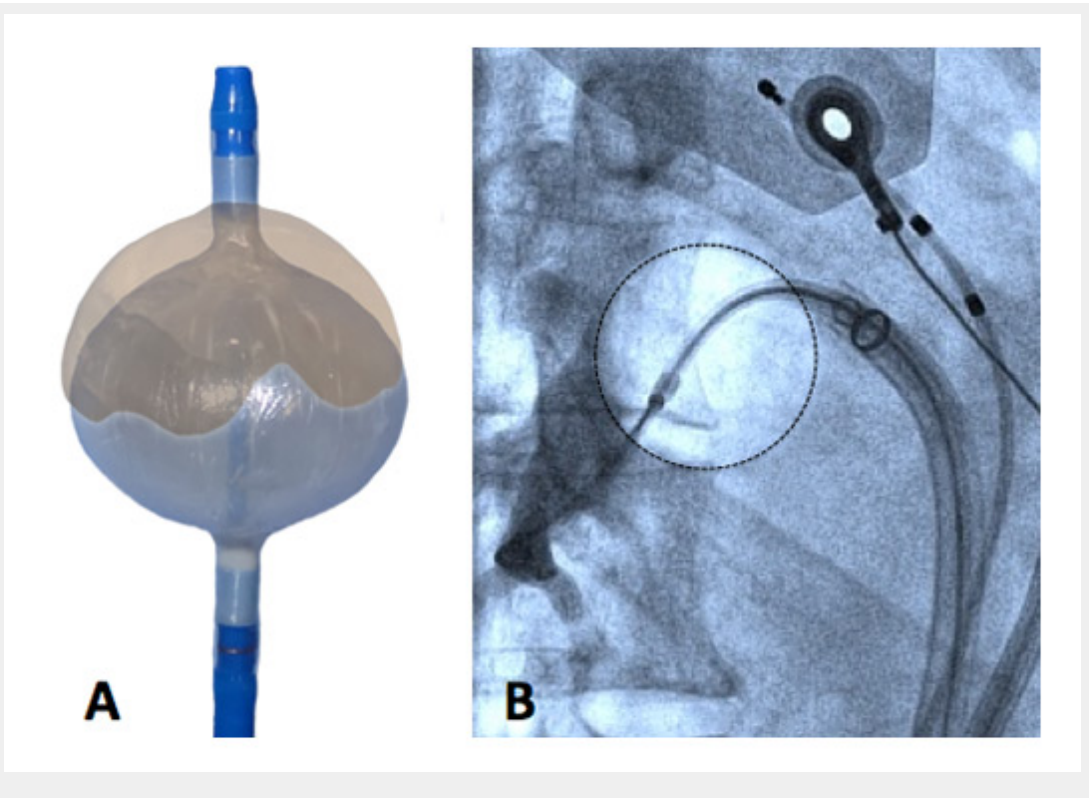
Figure 4 A: The cryoballoon is a balloon-based ablation system used for pulmonary vein isolation. The inflated cryoballoon has a diameter of 28 mm. The grey overlay shows the area where ice forms on the balloon during ablation. B: Fluoroscopic image before ablation at the right inferior pulmonary vein using the 28 mm cryoballoon. The actual balloon is encircled by a dotted line. Contrast media is injected into the pulmonary vein before ablation to ensure circumferential tissue contact required for effective lesion